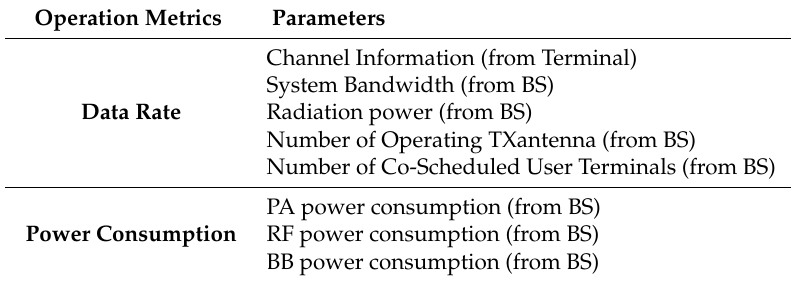
Table 3. The system parameters for the operation of energy-efficient BS. PA: power